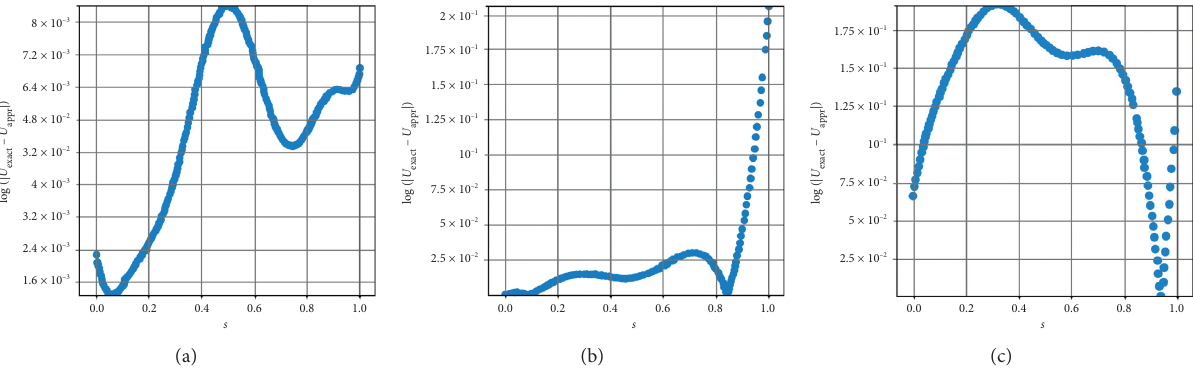
Figure 7: Comparison of networks’ convergence toward the exact solution of Example 2 using (a) Adam optimizer, (b) SGD optimizer, and (c)